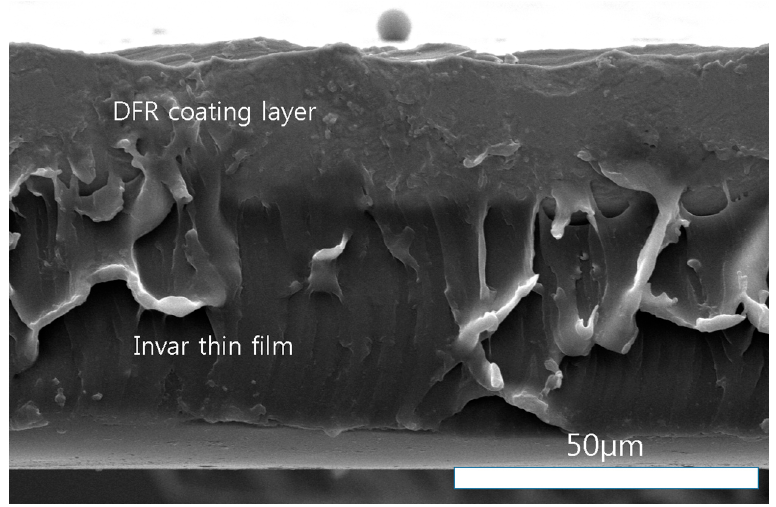
Figure 2. Sectional SEM image of DFR coated Invar thin film.